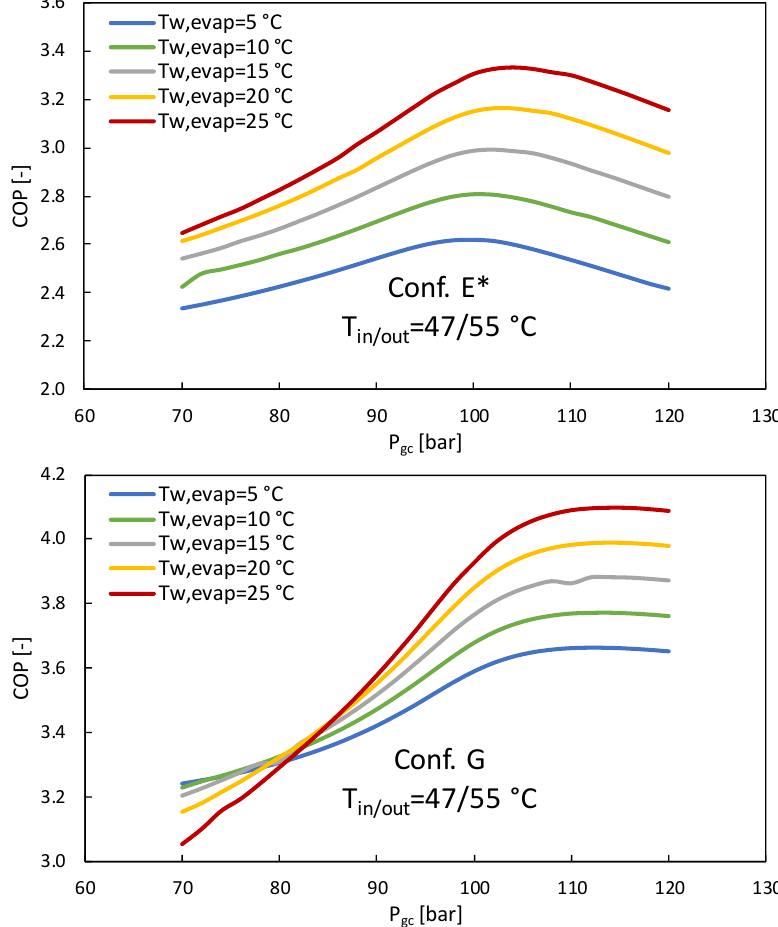
Figure 7. Influence of the evaporator inlet water temperature on the COP as a function of the gas cooler pressure for the case 47/55 °C for configurations Conf. E* ( up ) and Conf. G ( down ).